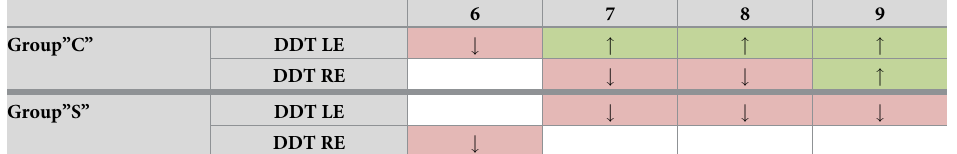
Table 17. Reversed lateralization pattern of dichotic listening deficit in DDT depending on the prevalence of APD, by age (fields in red or green indicate results below or within standard,